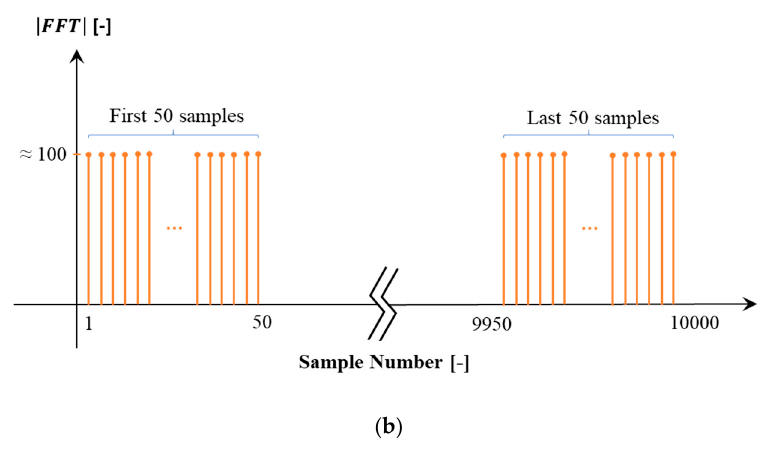
Figure 2. Designed sinc signal. ( a ) Time domain; ( b ) discrete Fourier transform (DFT) magnitude.